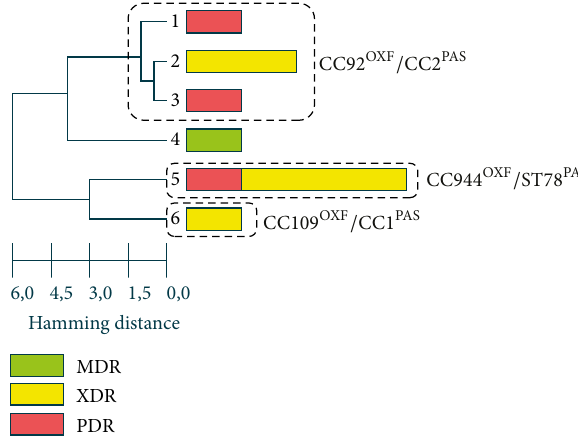
Figure 1: UPGMA clustering of SNP profiles of colistin nonsuscep- tible A. baumannii strains. The length of each rectangle depends on the number of isolates. International epidemic clones are marked with dashed lines. Color detailed the resistance categories (MDR, XDR, and PDR) of isolates within each